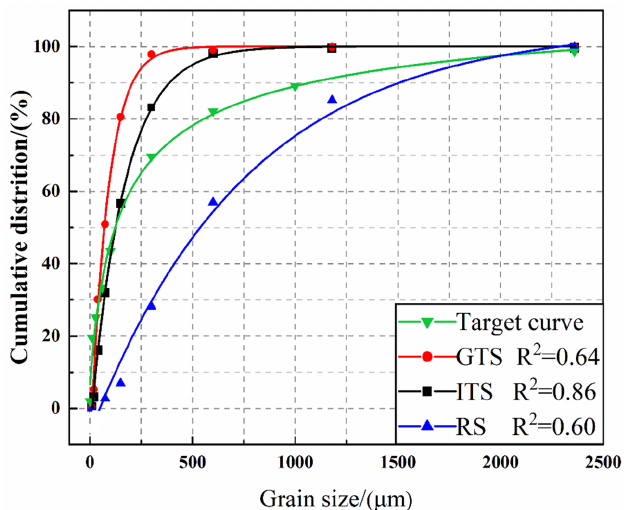
Figure 6. Size distribution curves of fine aggregate and target curves under Andreasen close packing model. packing